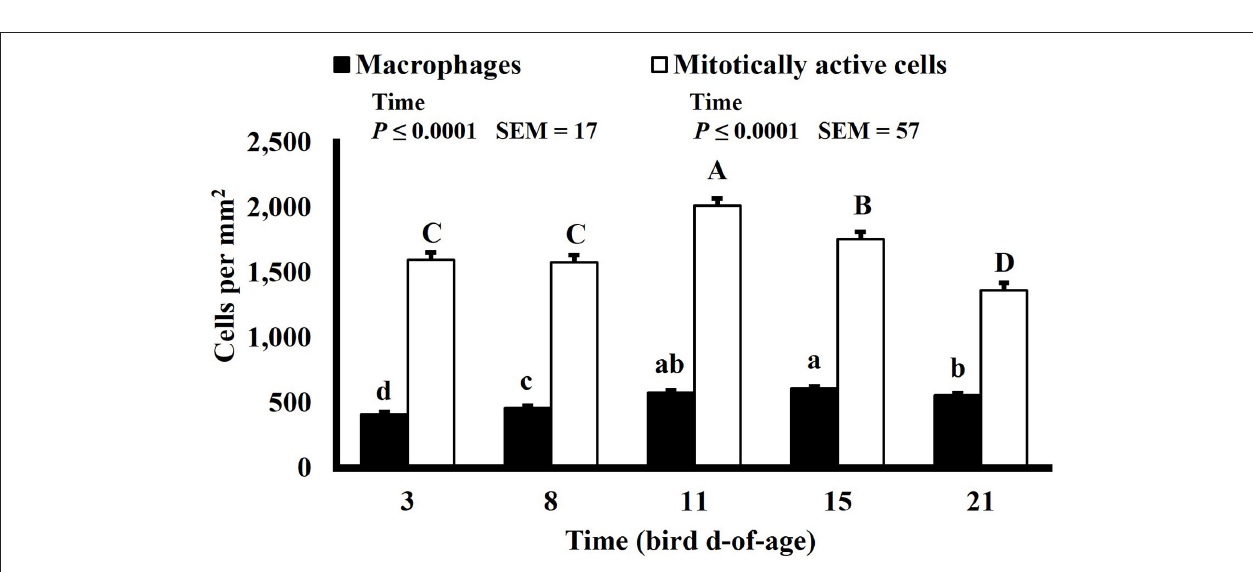
FIGURE 13 | Representative digital images illustrating immunofluorescence detection of macrophages (KUL01 + ), including pro-inflammatory and anti-inflammatory macrophages, and mitotically active (proliferating; BrdU + ) cells in duodenal (A,B) and ileal (C,D) cryosections of 21-d-old broilers. (A,C) Total macrophages (red, KUL01 + ). (B,D) Mitotically active cells (pink, BrdU + ). Scale bar = 100 µ